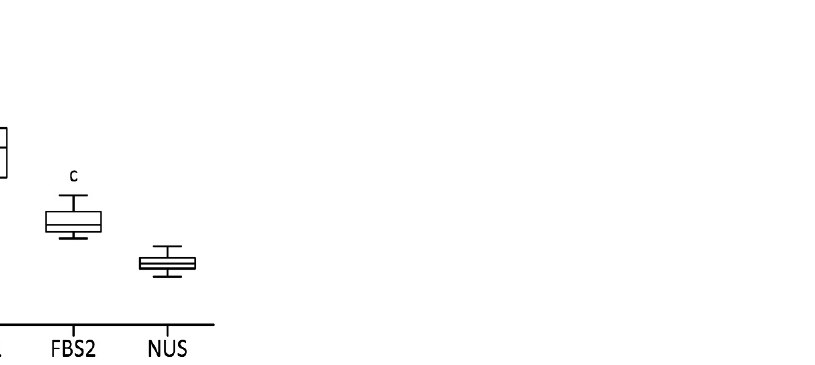
Figure 3. Surface markers CD14, CD16, CD163, and MHCII were assessed by flow cytometry and presented as the median fluorescence intensity (MFI). Relative expressions of CD80 and CD86 meas- ured by qPCR are presented as HPRT units. Boxplots represent data from the MDM culture with fetal bovine serum (FBS1 and FBS2) or with reduced-serum medium (NUS): median (line), first and third quartiles (box), and minimum and maximum (whiskers); flow cytometry: n = 18, qPCR: n = 12. Significant differences (Friedman test with Dunn’s multiple-comparison post hoc test) between groups are marked as follows: a FBS1 vs. FBS2, p < 0.05; b FBS1 vs. NUS, p < 0.05; c FBS2 vs. NUS, p < 0.05. 3.3. Respiratory Burst and Phagocytic Activity In order to confirm that reduced-serum culture conditions are suitable for in vitro functional studies of porcine macrophages, their phagocytic activity, respiratory burst, and cytokine production were assessed. Fluorescent-conjugated opsonized zymosan A bioparticles were used for MDM phagocytic activity detection by flow cytometry. Live MDMs were gated according to a gating strategy (Figure S2). About 20% of MDMs were found to be Alexa Fluor 488-positive (Figure 4). The highest proportion of phagocytic cells was found in the FBS1-supplemented MDM culture (median 25.05%), and the difference in comparison with the reduced-serum culture (median 18.55%) was considered signifi- cant ( p < 0.05). The macrophages derived in the presence of FBS2 showed comparable phagocytic activity (median 17.9%) to the reduced-serum culture. Reactive oxygen species (ROS) production was measured after stimulation with PMA using a chemiluminescence assay. The PMA-stimulated/unstimulated ratios of samples were calculated from integrals of chemiluminescence intensity (Figure 4). The ratio values were nearly identical for cul- tures supplemented with FBS1 (median = 40.4) and NUS (median = 41.6). Nevertheless, a significant difference ( p < 0.05) was found between FBS1 and FBS2 (median = 31.8) when data were evaluated using Friedman test paired with Dunn’s multiple-comparison post hoc test. Taken together, these data indicate that reduced-serum conditions had no nega- tive impact on macrophage function in terms of respiratory burst and phagocytic activity.